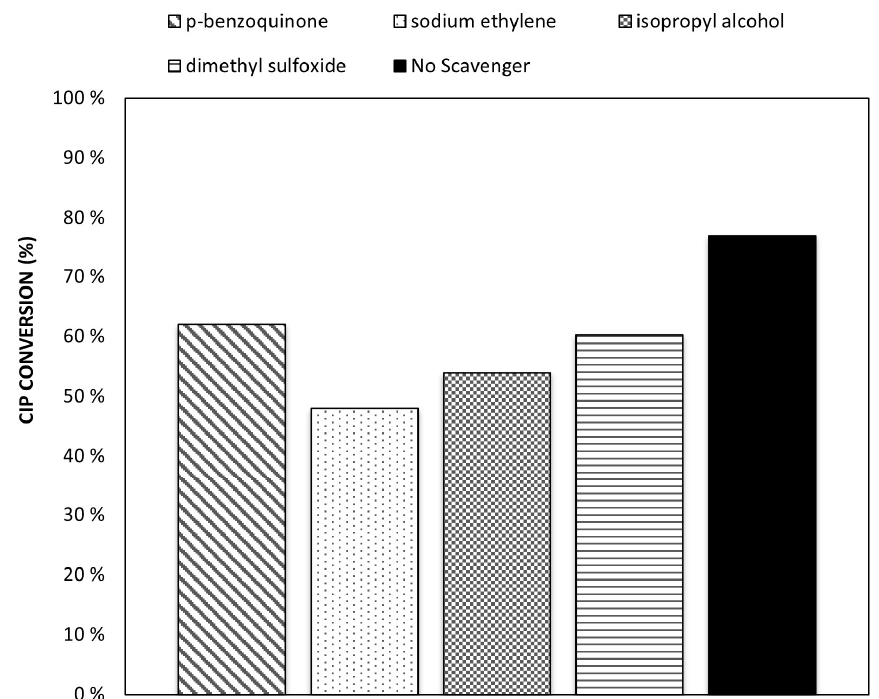
Figure 11. Effect of different scavengers on CIP conversion: p-benzoquinone ( • O 2 − trap), sodium ethylene (h + trap), isopropyl alcohol ( • OH trap), dimethyl sulfoxide (e − trap).